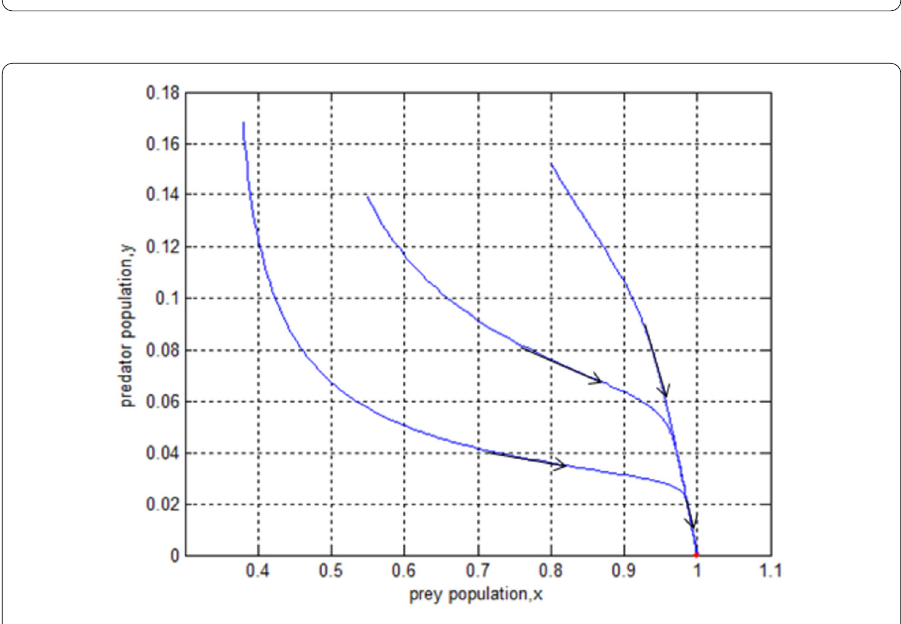
Figure 2 E s 2 = (1,0) is